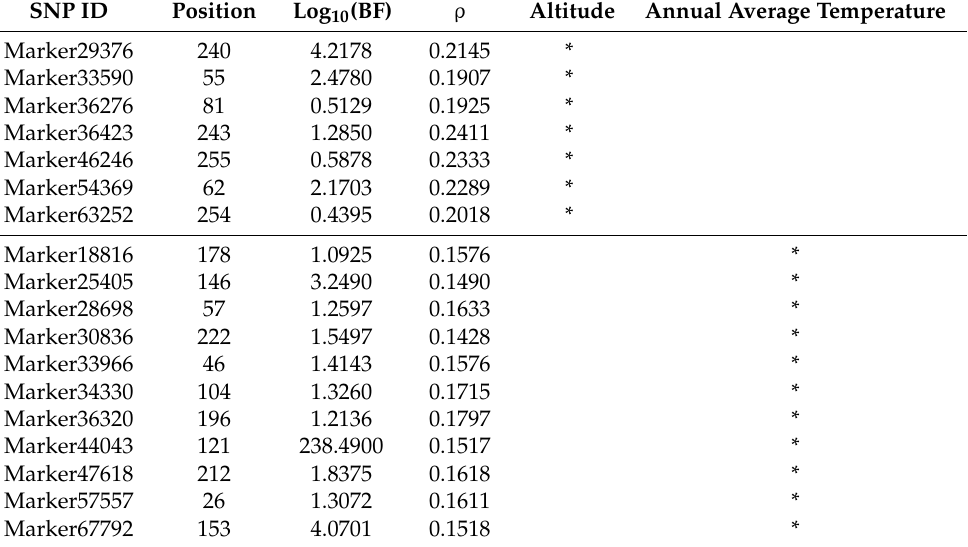
Table 6. Summary of candidate SNP markers associated with two different environmental variables.